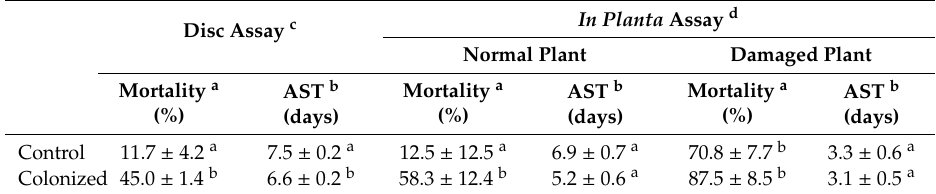
Table 1. E ff ects of exposure of S. littoralis larvae to M. brunneum -colonized plants. Table 1. Effects of exposure of S. littoralis larvae to M. brunneum -colonized plants. In Planta Assay d Disc Assay c In Planta Assay d Normal Plant Damaged Plant Disc Assay c Normal Plant Damaged Plant